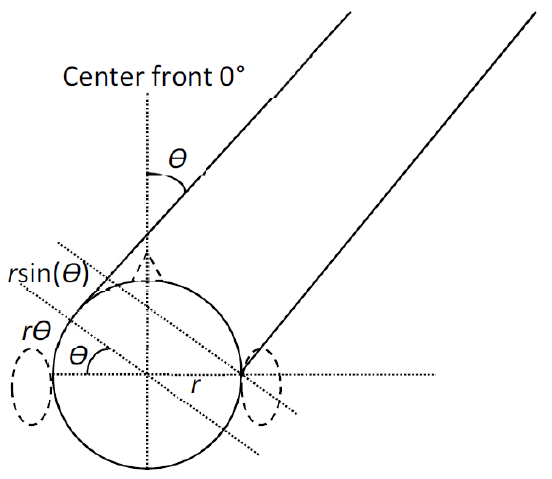
Figure 12. Power spectral density of: ( a ) rock, ( b ) country, ( c ) jazz, and ( d ) electronic music.